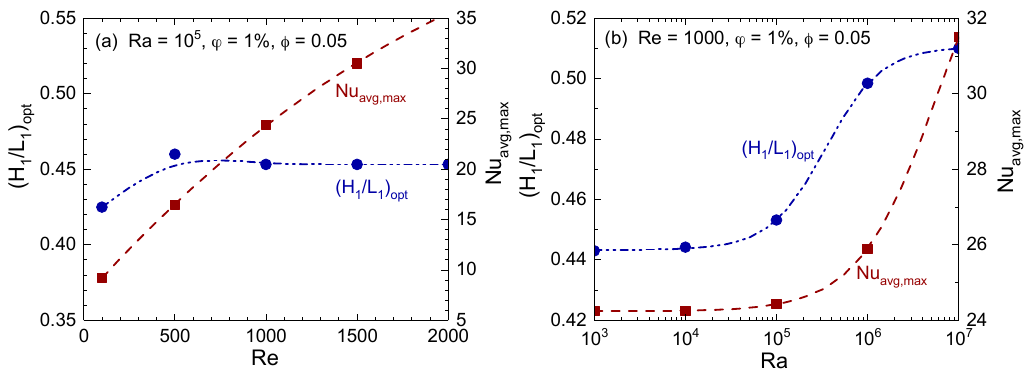
Figure 18. Optimum fin dimension (( H 1 / L 1 ) opt ) and corresponding average Nusselt number (Nu avg,max ) as a function of ( a ) Reynolds number and ( b ) Rayleigh number for ϕ = 1% and φ = 0.05. Symbols are the numerical data points and the lines are the best fit.